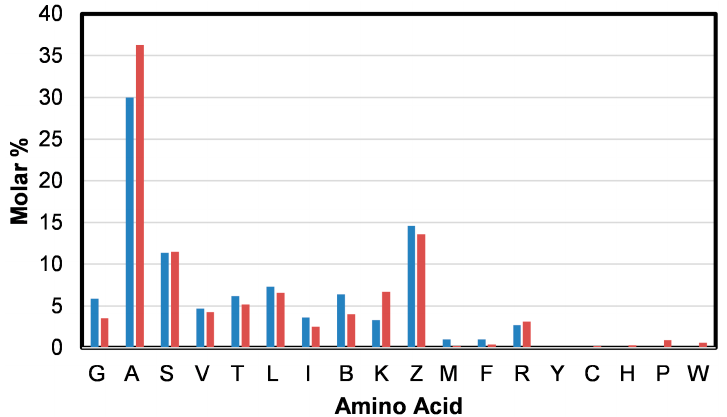
Figure 3. The amino acid composition (molar percentage) determined for B. terrestris silk (blue) and